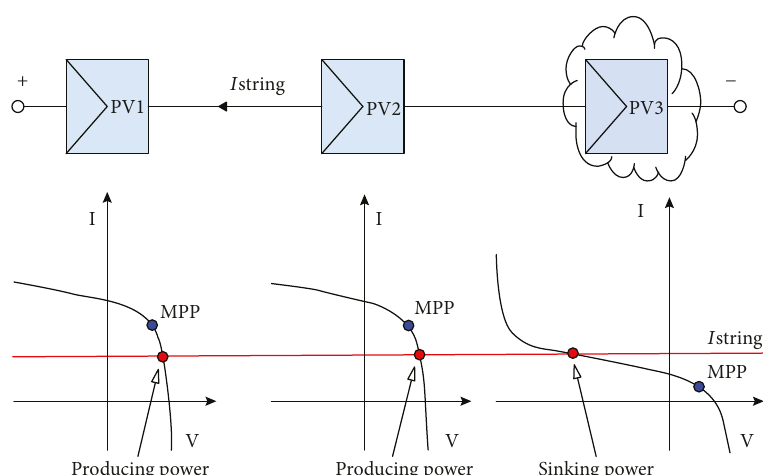
Figure 5: Partially shaded string of PV cells showing reverse bias voltage of the shaded cells. Each cell ’ s electrical characteristics are shown with the MPP and the operating point according to the string I